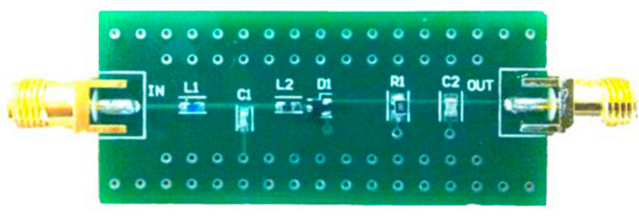
Figure 4. PCB implementation of the simple RFED WuR implemented with discrete components.